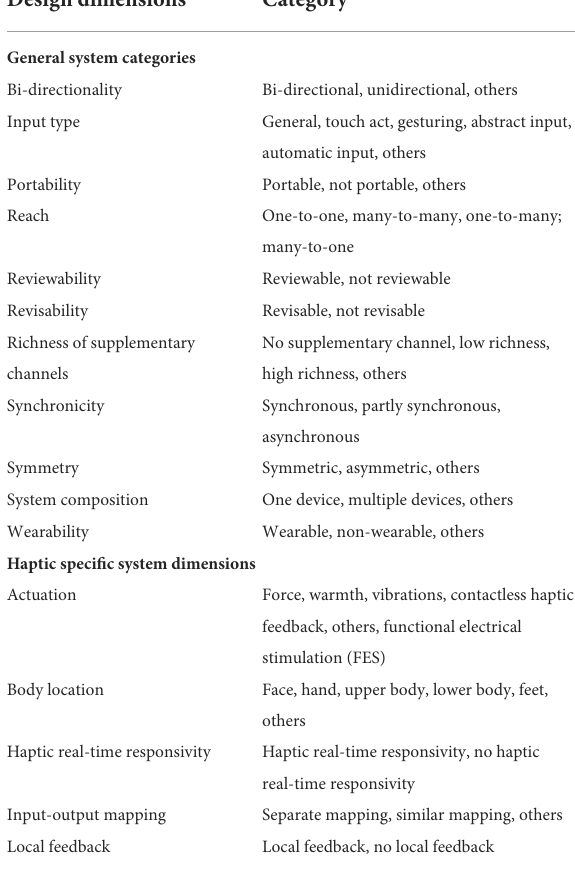
TABLE 1 Overview of the dimensions and corresponding categories used for mapping the design space of Affective Haptic Devices (AHDs), which were based on communication and system